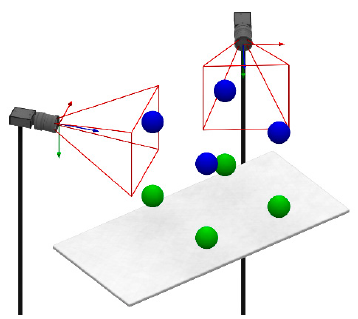
Figure 15. Part of test points to calculate the head-tracking accuracy. Presented eight points are near the edges of the calibrated volume. Table 3. Head-tracking reprojection error in calibration volume.